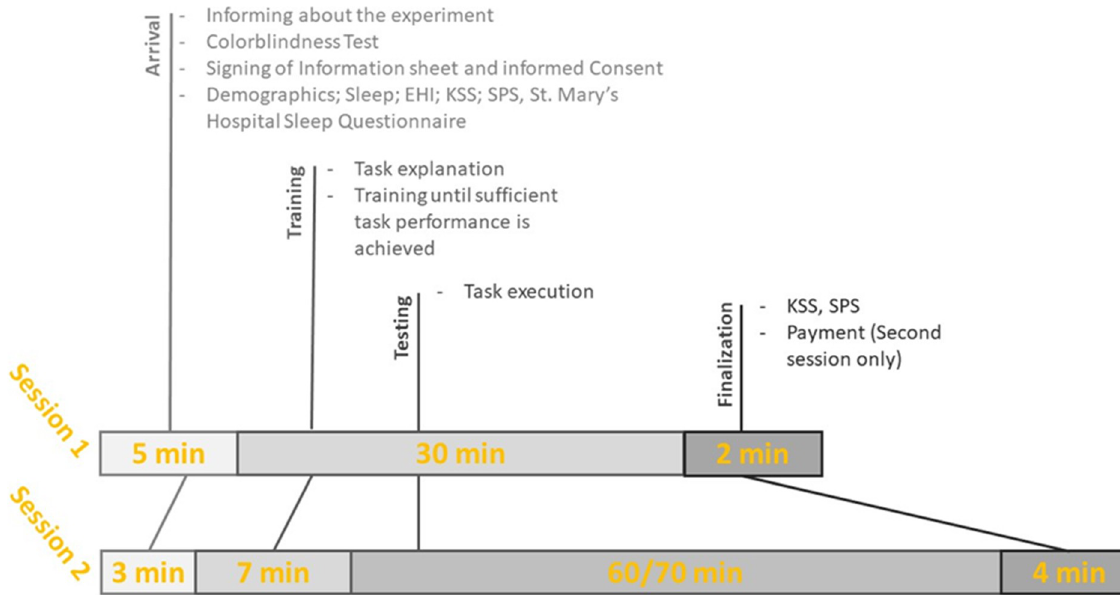
Fig 5. Timeline of the two sessions for Experiments 1 and